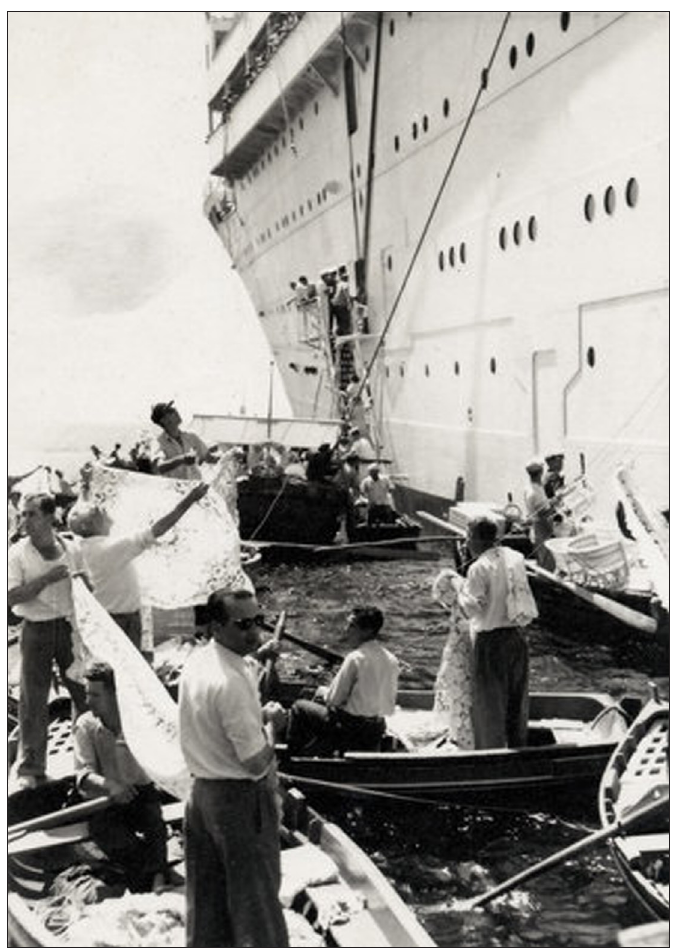
Figure 2: Bombote and Bomboteiros in Funchal bay. Photo: Vicentes Photography